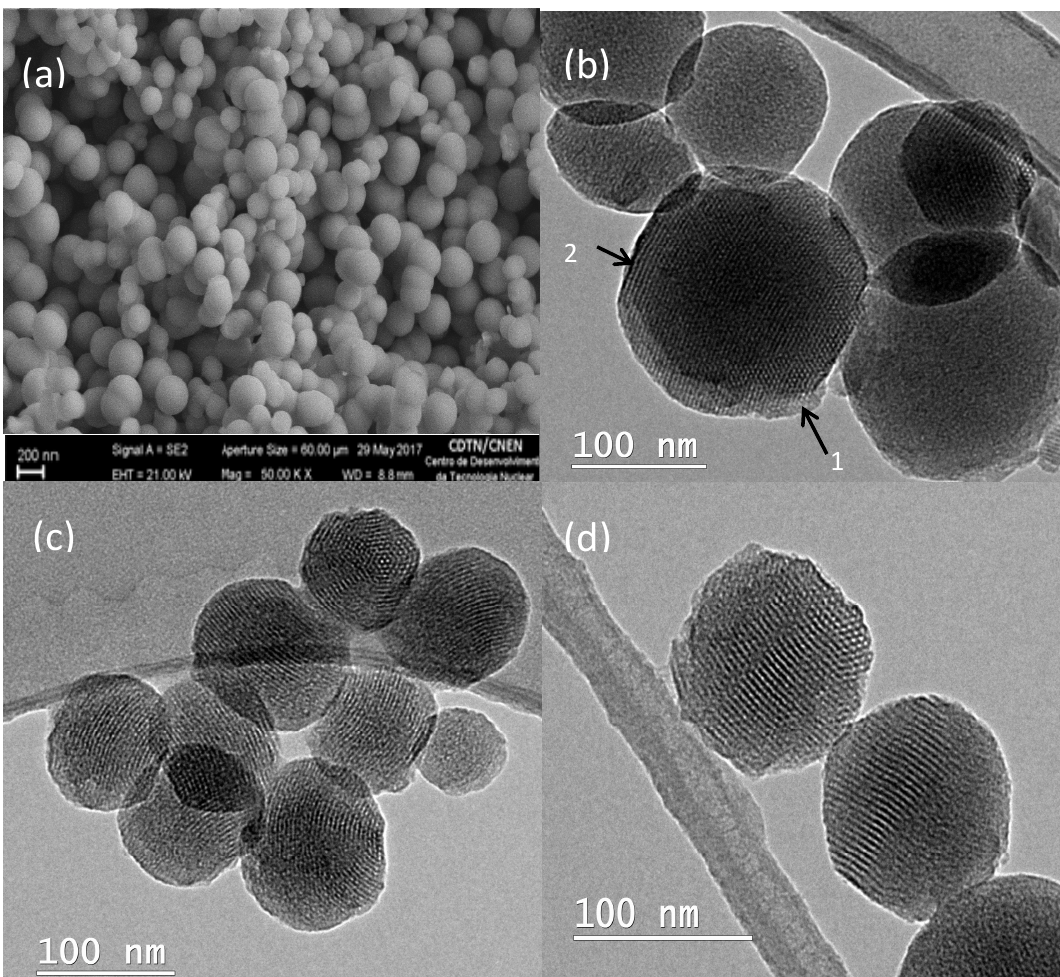
Figure 1. ( a ) Scanning Electron Microscopy (SEM) images of MCM-41 and Transmition Electron